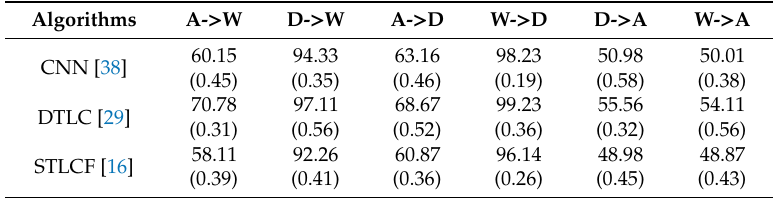
Table 2. Average accuracy rate (%) with absolute value of standard variation on O ffi ce-31